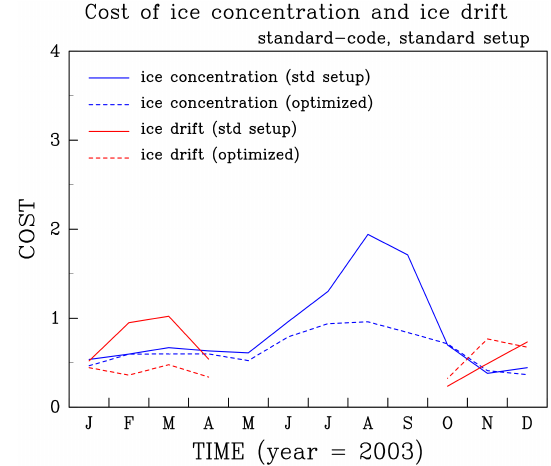
Fig. 7. Time series of ice concentration cost (blue lines) and ice